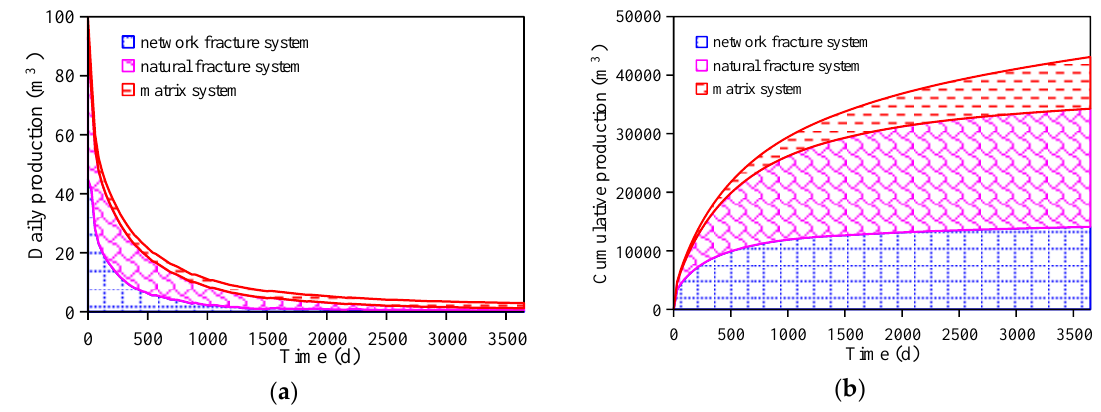
Figure 7. Productivity contribution curves of three systems during SRV-fractured horizontal well production in a tight oil reservoir. ( a ) Oil production rate. ( b ) Cumulative oil production. Table 3. DPCR and CPCR of three systems to SRV-fractured horizontal well productivity in different development stages of tight oil